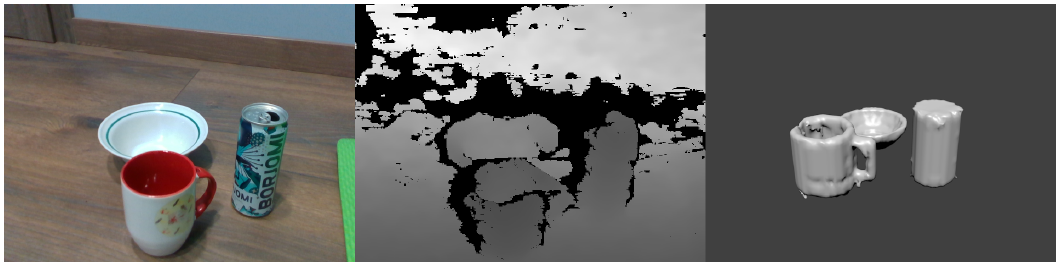
Figure 15. An example of reconstruction of multiple objects in the scene: segmented and classified RGB frame ( left ), depth frame ( middle ), and predicted depth mask ( right